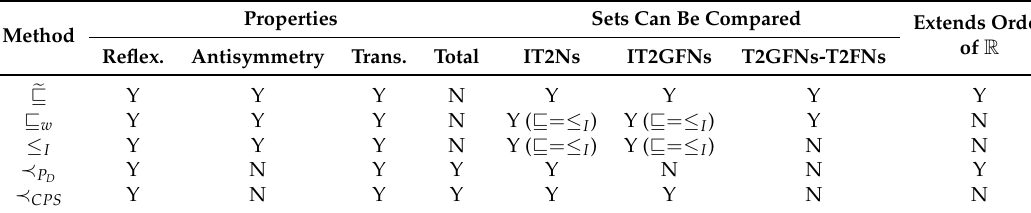
Table 1. Comparative results for several ranking methods, “Y” = Yes, “N” =